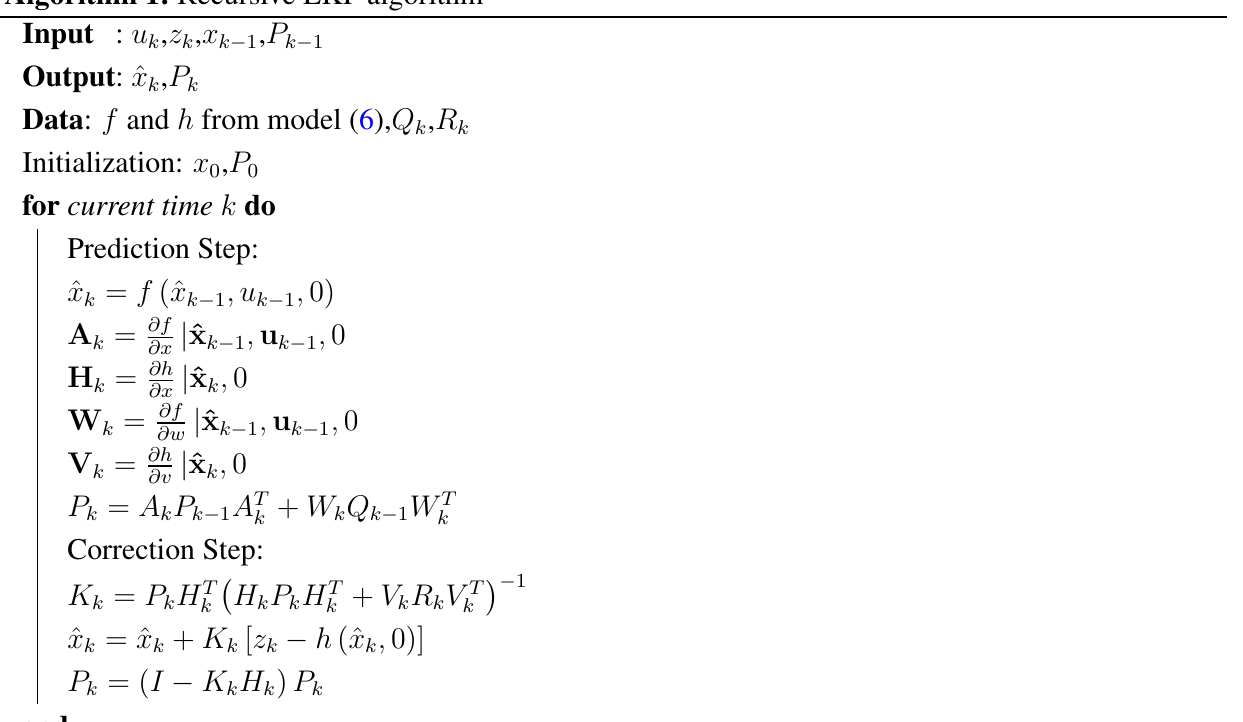
Algorithm 1: Recursive EKF